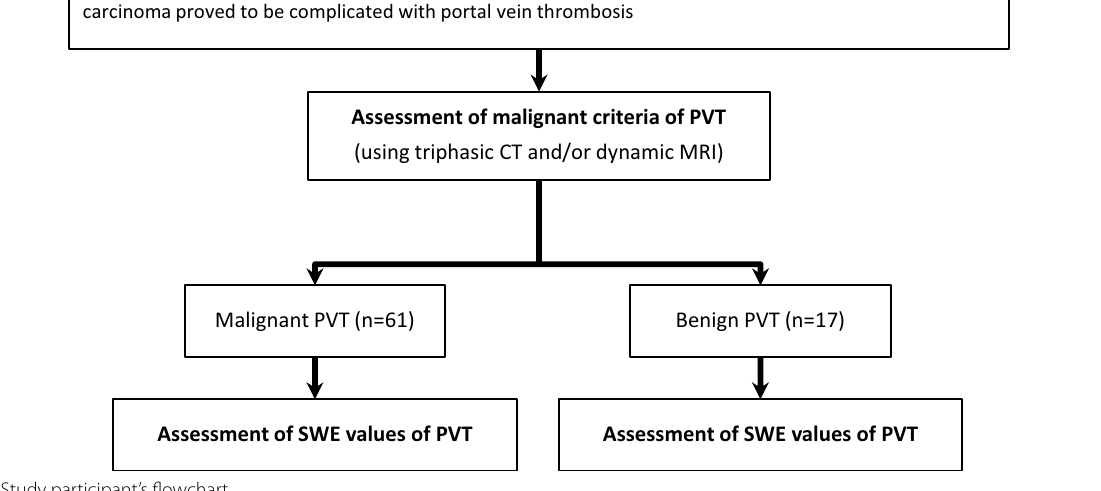
Fig. 1 Study participant’s